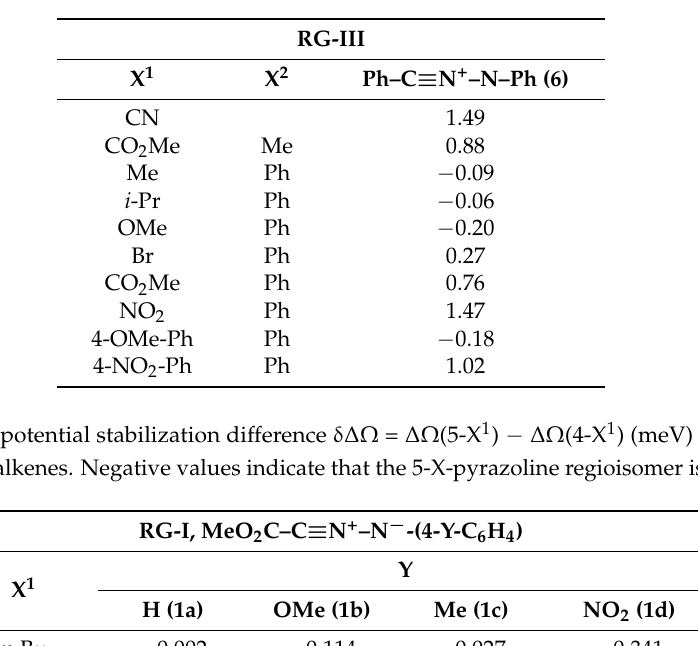
Table 9. Electron chemical potential difference µ (diphenylnitrilimine 6 )– µ (ethene) in eV for the RG-III. Positive values indicate that the nitrilimine transfers electrons to the ethene.